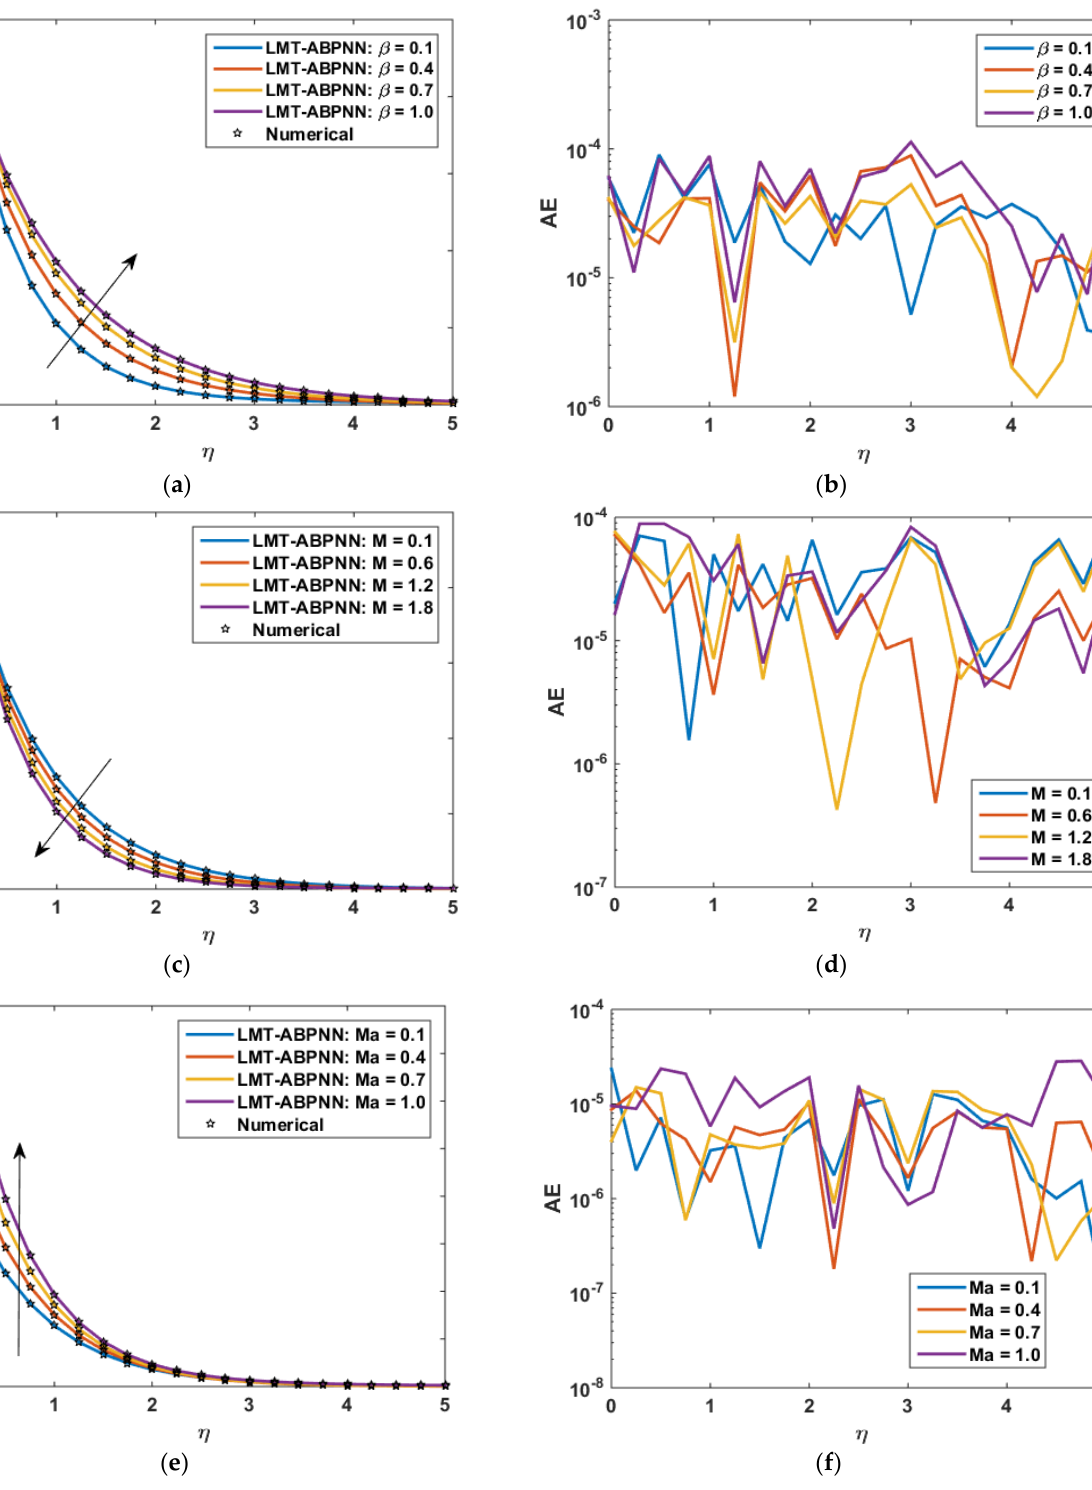
Figure 13. Assessment of LMT-ABPNN for 𝑓′(𝜂) with reference dataset of MHD-SGFM. ( a ) For variation of 𝛽 for f ′, ( b ) AE for MHD-SGFM, ( c ) For variation of 𝑀 for f ′, ( d ) AE for MHD-SGFM, ( e ) For variation of 𝑀𝑎 for f′, ( f ) AE for MHD-SGFM.